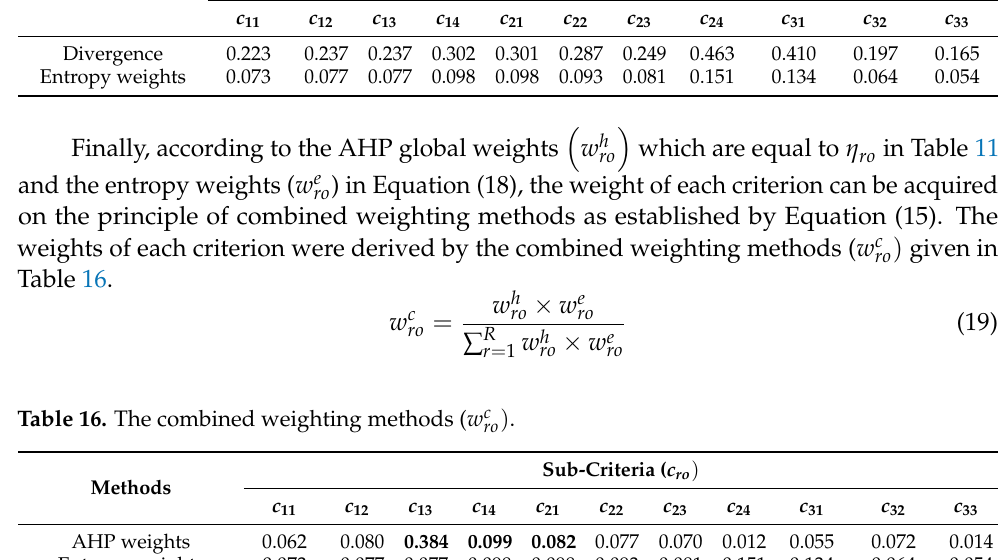
Sub-Criteria ( c ro